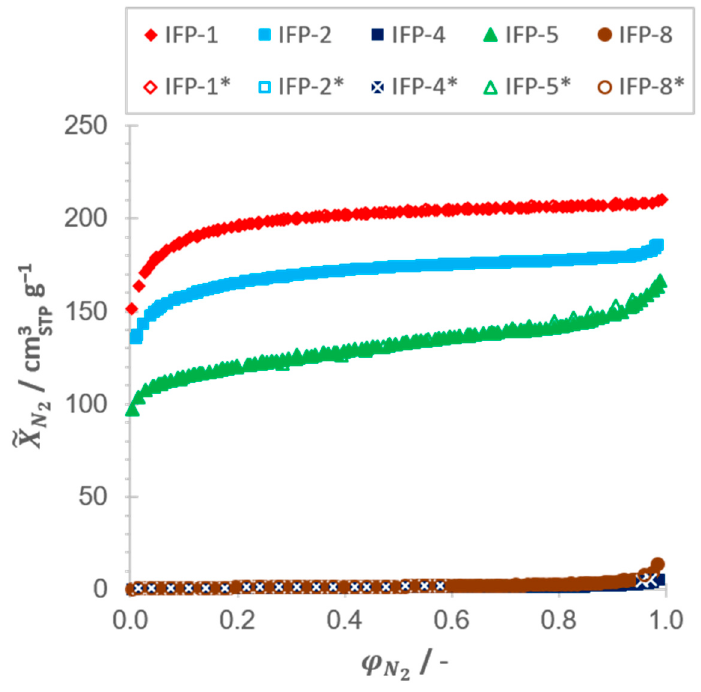
Figure 5. Adsorption and desorption (*) isotherms of N 2 on all IFP samples at T = 77.4 K.